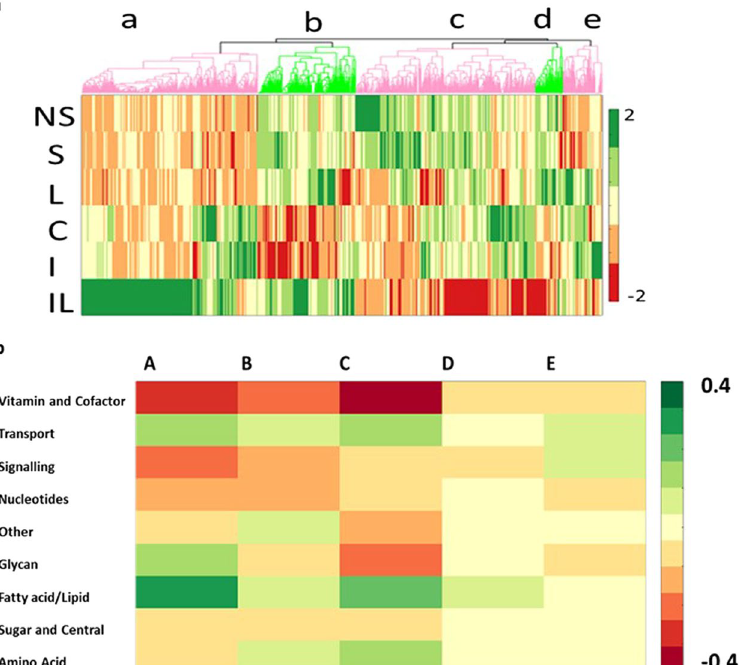
Figure 7. Metabolic changes between sepsis survivors and non-survivors in the context of iHUVEC2552. ( a ) Cluster analysis of 2-fold changes in flux between the two sepsis specific metabolic models and the IFN/LPS cell culture metabolic model (base model). NS: non-survivor, S: Survivor C: Control, I: IFN γ , L: LPS, IL: IFN γ /LPS. Sorted by super subsystem. ( b ) The distribution across metabolism (classified by super subsystem) of reactions within each cluster normalized to total reactions of each super subsystem.